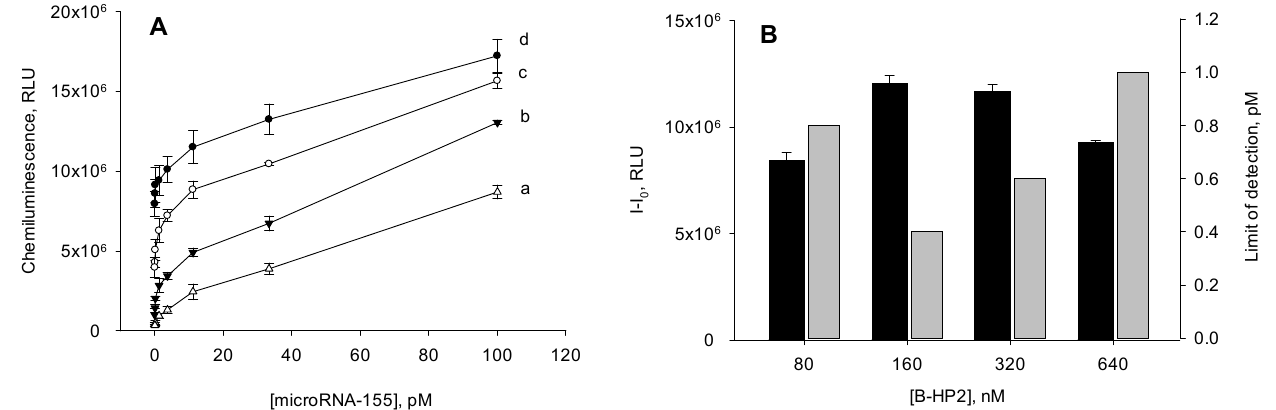
Figure 4. Effect of the B-HP2 probe concentration in the reaction solution on ( A ) the behavior of the calibration curves, ( B ) chemiluminescence signal (I–I 0 ) (black columns), and limit of detection (gray columns) of the amplified microRNA-155 assay. The mismatched catalytic hairpin assembly reaction was carried out in 10 mM Tris-HCl with pH 7.2 containing 20 mM MgCl 2 at 25 °C for 1 h. The concentration of the B-HP2 probe was (a) 80, (b) 160, (c) 320, and (d) 640 mM. The value of the chemiluminescence signal (I–I 0 ) was calculated as the difference between the chemiluminescence intensities recorded in the presence (100 pM) and in the absence of microRNA-155. The detection limit was calculated using the 3 σ rule.